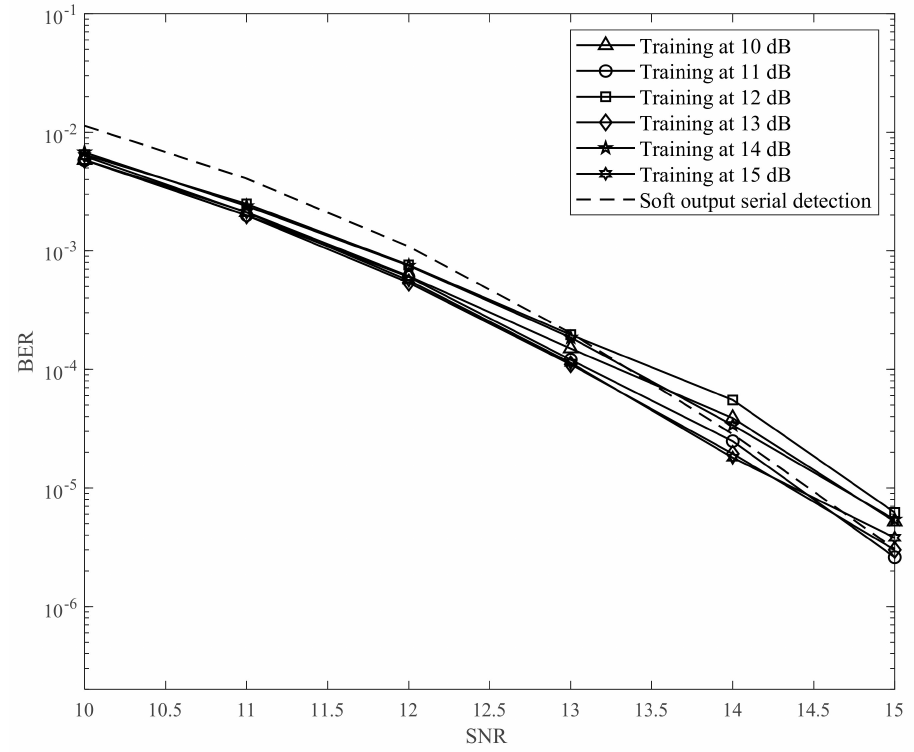
Figure 11. The BER performance of serial detection with two hidden layers neural